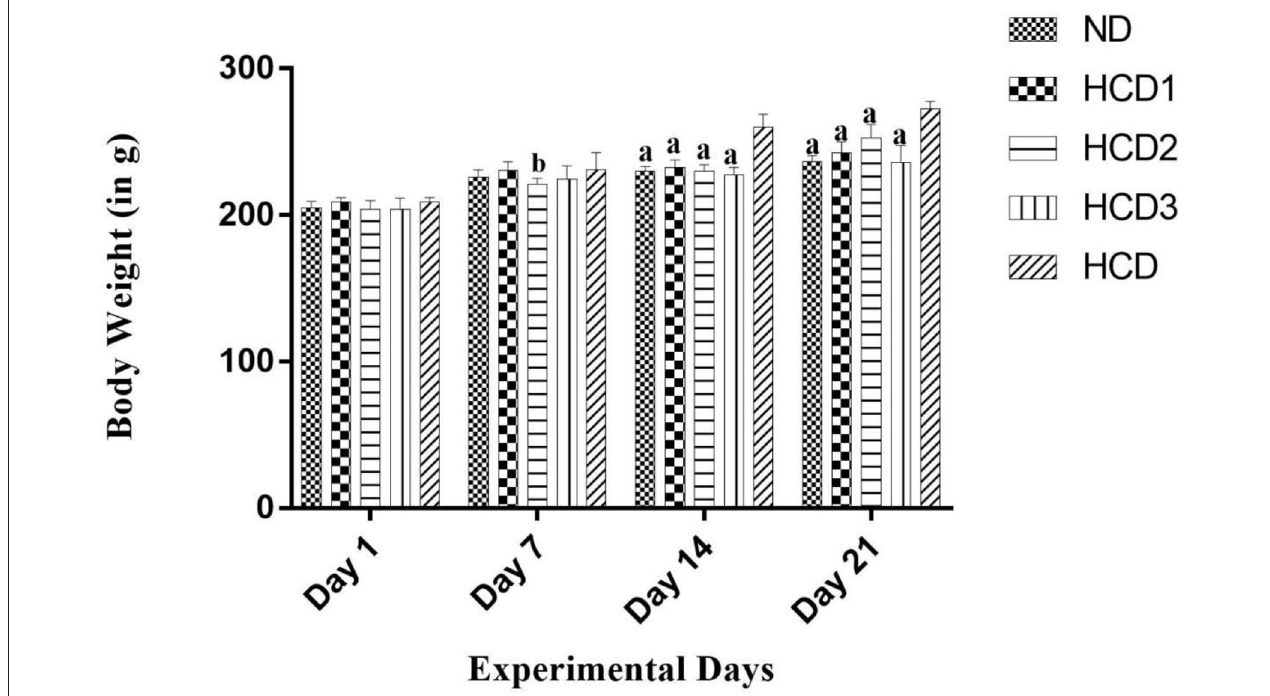
FIGURE 4 | Bodyweight increment in all experimental groups after 21 days. Results are shown as mean ± SEM ( n = 6). “a” denotes p ≤ 0.0001; “b” denotes p ≤ 0.001 vs. Hypercholesterolemic diet control (HCD) group.